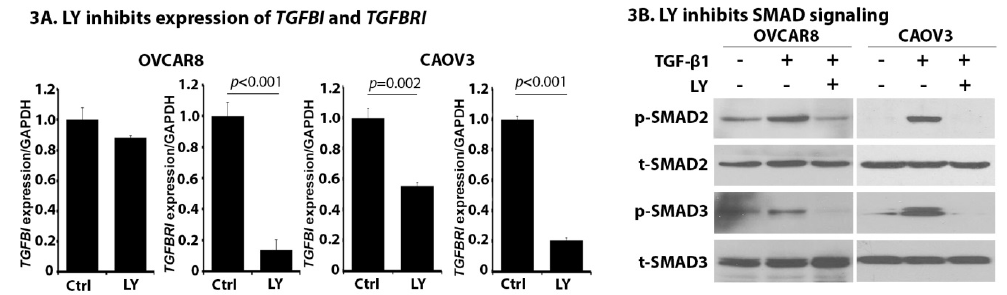
Figure 3. LY inhibits TGF- β signaling in OC cells. ( A ) OVCAR8 and CAOV3 cells were treated with LY for 24 h and total RNA collected for qPCR analysis. Expression of TGFB1 and TGFBRI are shown. ( B ) OVCAR8 and CAOV3 cells were treated with TGF- β 1 (5 ng/mL) with or without the pre-treatment of LY and total protein lysates were collected for Western blot analysis on the expression of p-SMAD2 and p-SMAD3. Total SMAD2 and SMAD3 were used as loading controls. All data represent the mean ± SD of three independent experiments.